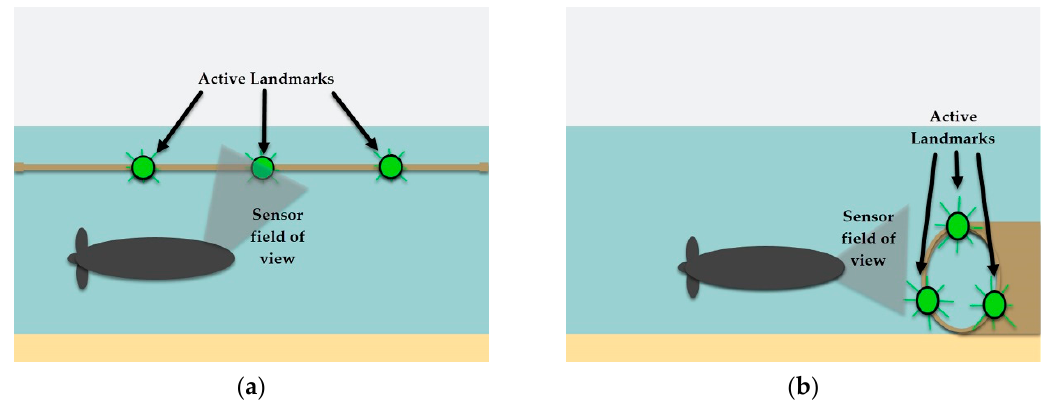
Figure 11. Optical localization systems based on active landmarks. ( a ) AUV following an array of active markers, ( b ) AUV locating an entrance by an arrangement of active markers.